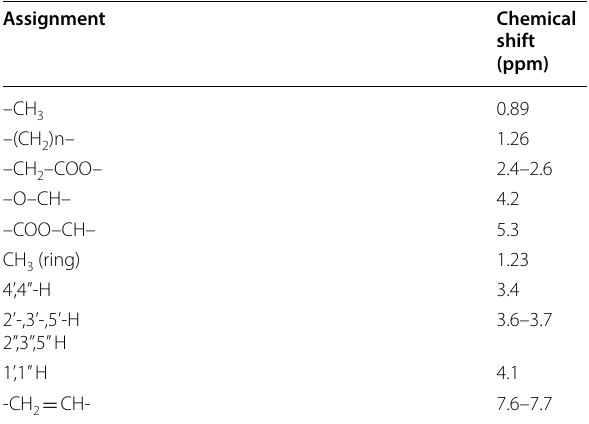
Table 1 Chemical shift assignments of extracted RLs in 1